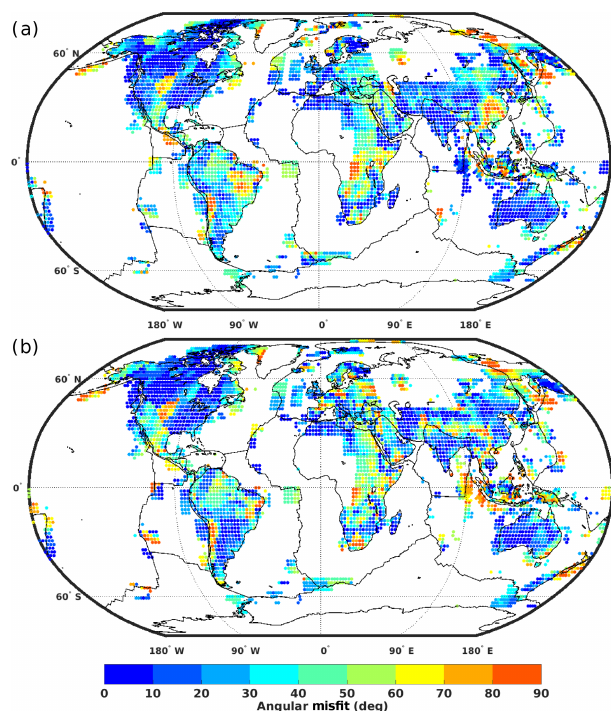
Figure 6. Angular misfit between the observed (WSM 2016) and total modeled stress directions with (a) TM1 and (b) TM2 upper mantle thermal and density